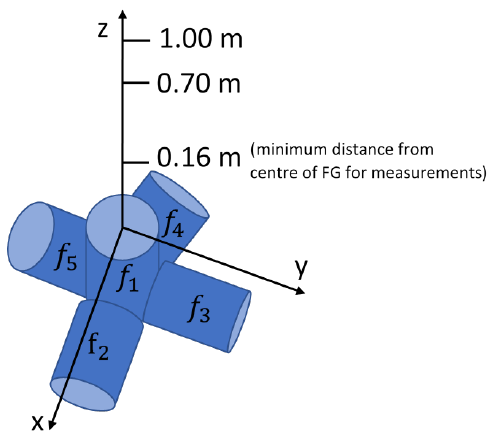
Figure 2. Coordinate system with reference to the field generator (FG). Table 1. Relative SD of the induced voltage at 0.7 m and 1 m from FG, before and after hardware improvement, and their relative